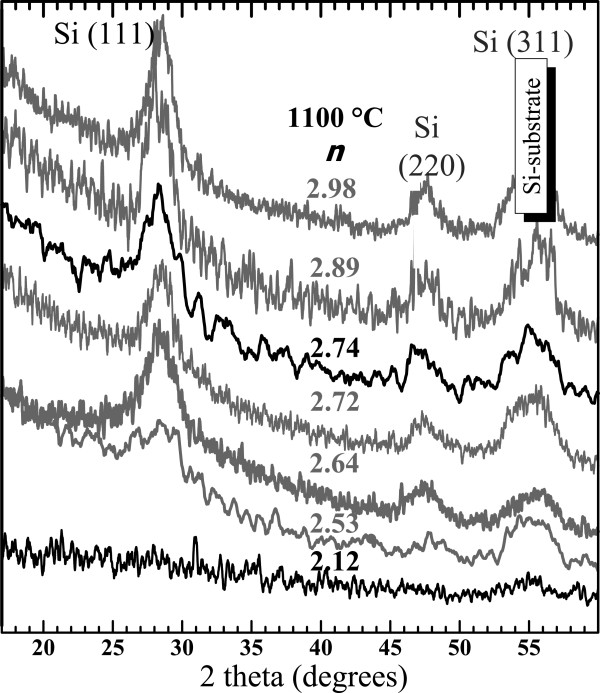
Evolution of XRD pattern of 1100°C-annealed SiNxlayers with the refractive index. XRD curves of thin films produced by the N2-reactive and the co-sputtering methods are displayed in black and gray, respectively.